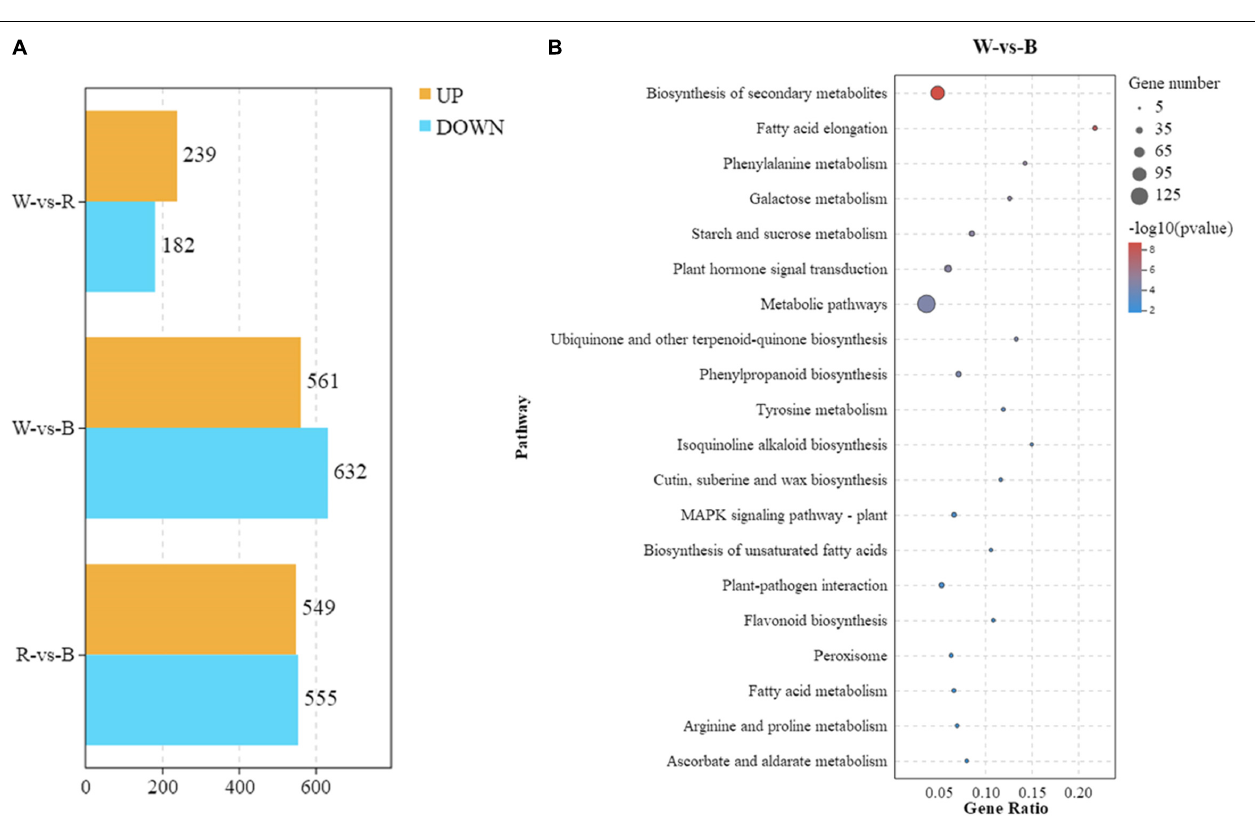
FIGURE 3 | Analysis of transcriptome data and SA transcription level. (A) Numbers of DEGs between different light treatments. (B) KEGG analysis between W-vs.-B treatment groups. Y-axis represents pathways, while x-axis represents Rich Factor. The Rich Factor means the degree of DEGs enrichment in each pathway, the bigger the Rich Factor the greater the DEGs enrichment. Each bubble represents a pathway, and the size of the bubble represents the number of target genes contained in the pathway. Dots of various sizes represent the number of DEGs accumulated in each pathway. The larger the point, the more DEG ( P < 0.05). The color of the bubble represents the significant degree of enrichment of the